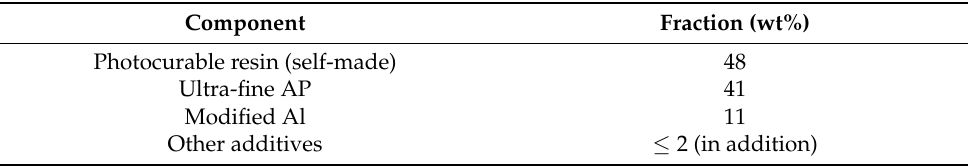
Table 2. Description of the energetic slurry composition.